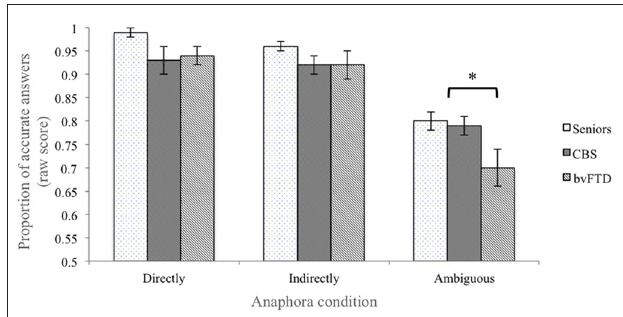
FIGURE 1 | Performance accuracy in the behavioral task. Behavioral performance of healthy seniors, corticobasal syndrome (CBS) patients and bvFTD patients. The error bars represent the standard error of the mean. The “ ∗ ” represents the contrast who reach the statistical significance (see “Results” Section).